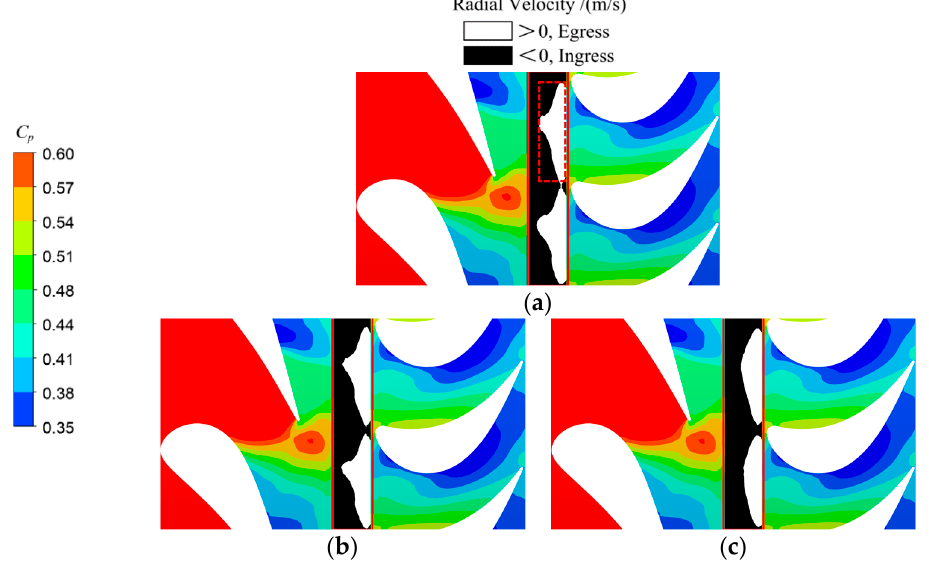
Figure 20. Radial velocity contour distributions at the clearance outlet and static pressure coefficient distributions at the endwall for IF = 0.6%. ( a ) Seal-A; ( b ) Seal-B; ( c ) Seal-C.